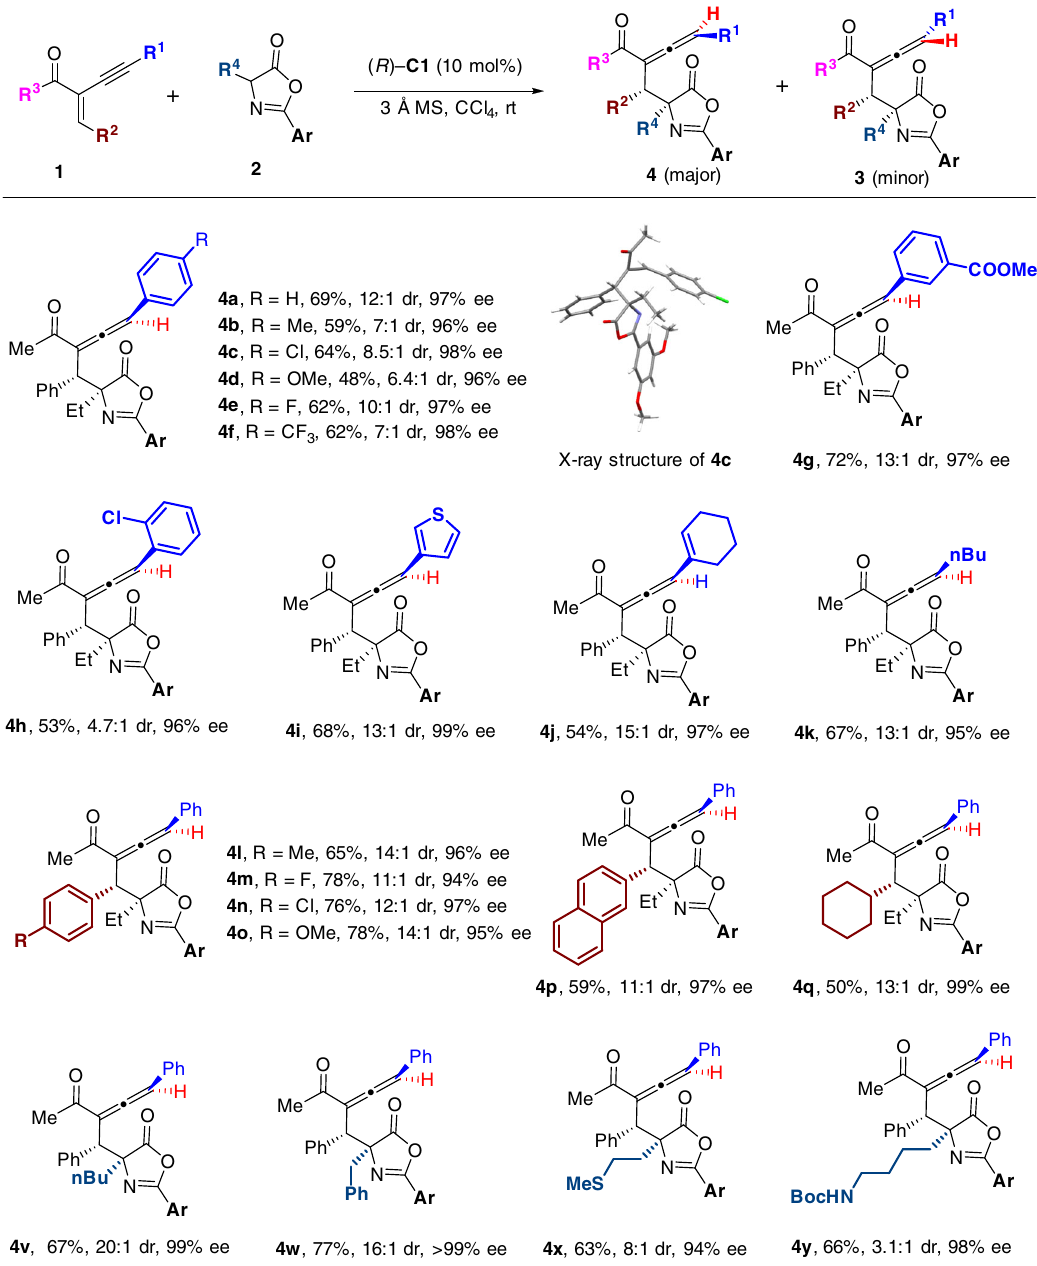
Fig. 3 Scope for asymmetric synthesis of trisubstituted allenes 4 catalyzed by CPA catalyst (R)-C1. Unless otherwise noted, the reaction conditions were the same with those indicated in Fig. 2, except ( R )- C1 catalyst (10 mol%) was used instead. Ar =